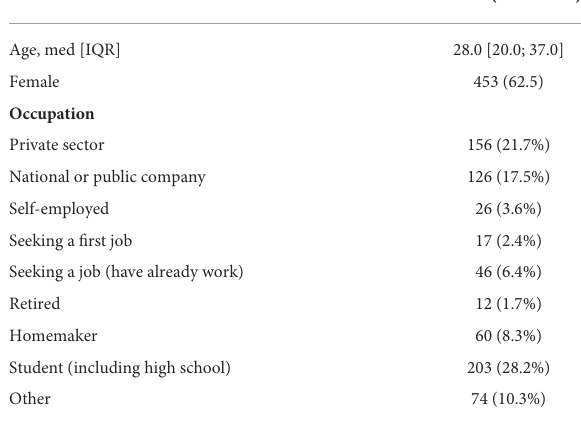
TABLE 1 Baseline characteristics of the study